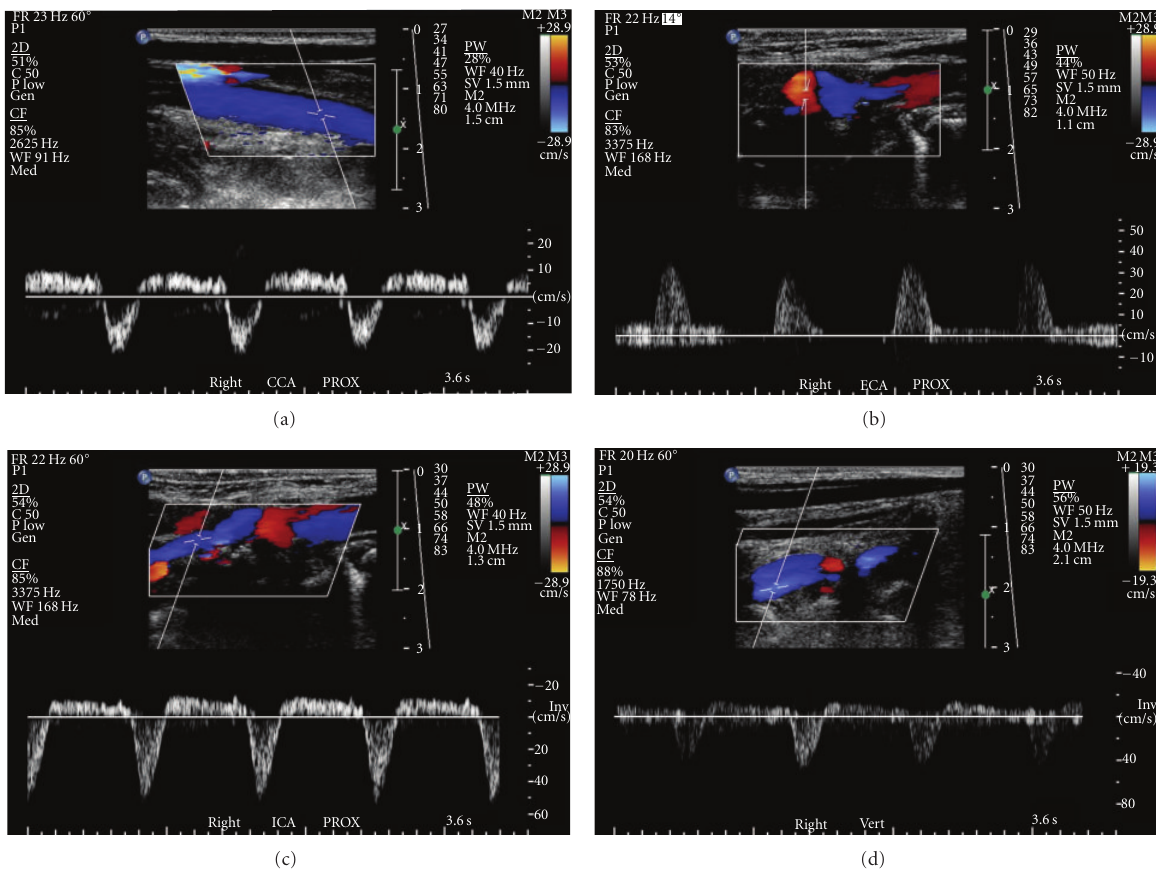
Figure 1: Color and pulsed-wave Doppler showing flow in right carotid and vertebral arteries. (a) To- and- fro with mainly retrograde blood flow in right common carotid artery. (b) Right external carotid artery with reversal of blood flow. (c) To- and- fro with mainly retrograde blood flow in right internal carotid artery. (d) Bidirectional and primarily reversed blood flow in right vertebral artery. Flow in the vertebral vein and the vertebral artery are in the same direction (toward the heart) and shown in blue. Note all arterial color Doppler flows are retrograde in these images.